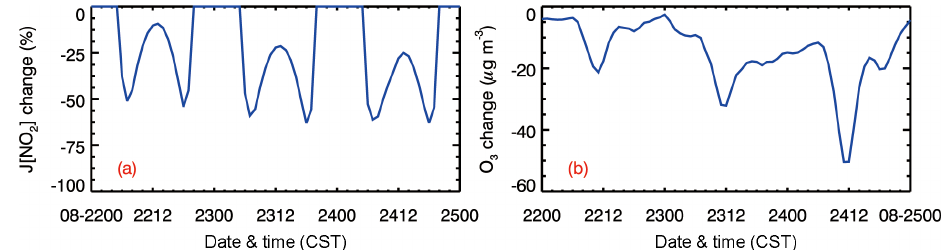
Figure 15. Diurnal variations of the change in (a) J [NO 2 ] and (b) O 3 concentrations averaged in Xi’an and surrounding areas due to aerosol effects from 22 to 24 August